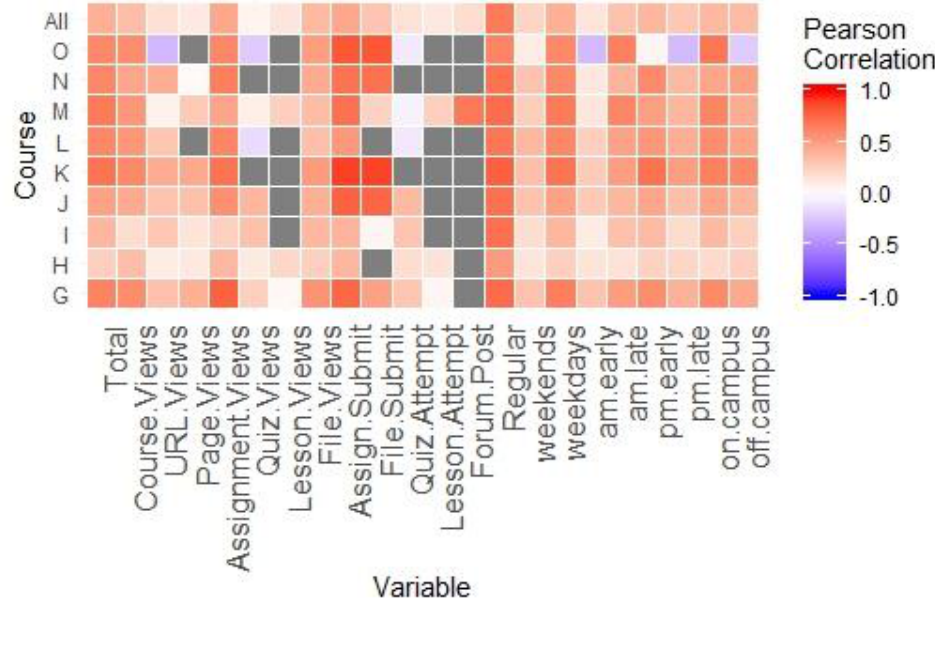
Figure 2: Correlation between percentage mark and predictor variables It is apparent that in general there is a positive linear relationship between frequency of activity on Moodle and student mark. Variables showing highest correlations (>0.4) with percentage mark for the whole dataset are login regularity, assignment views, assignment submissions, total activity and weekday activity.